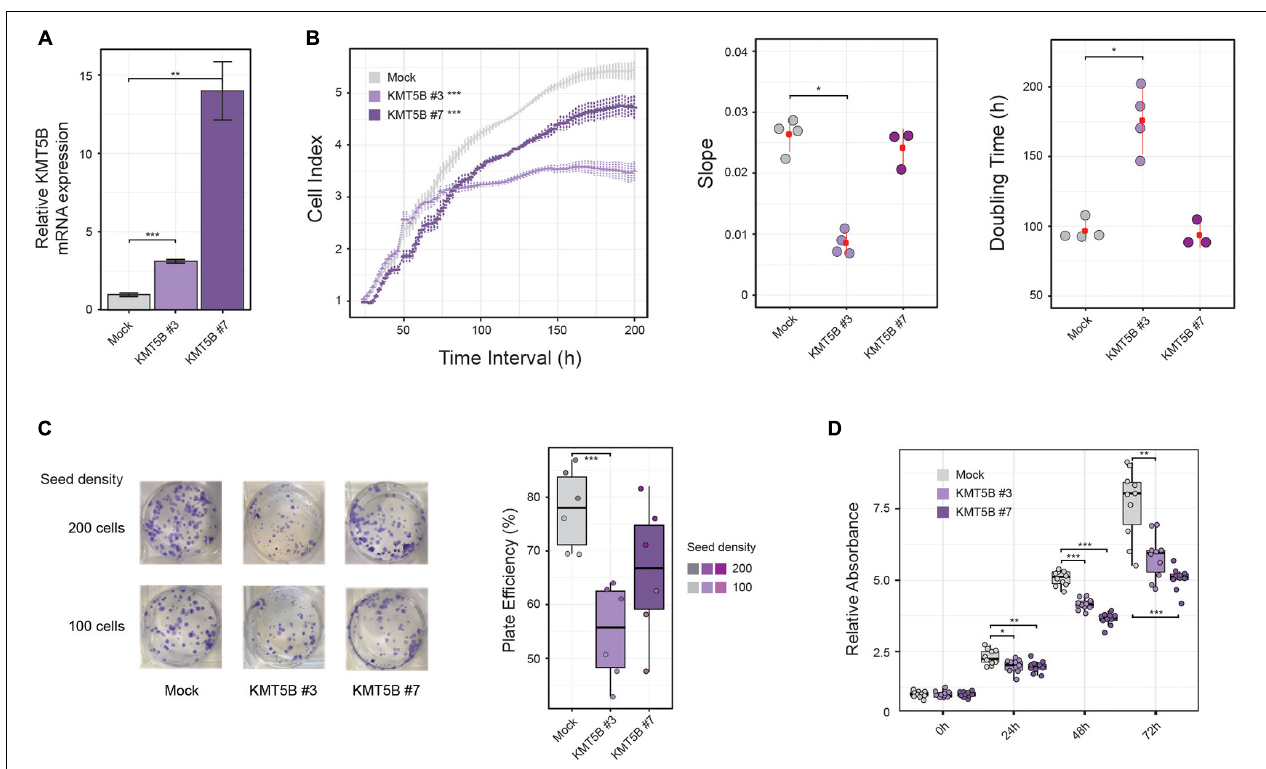
FIGURE 3 | In vitro effect of KMT5B ectopic expression. Human GBM cell line LN-229 was transfected with an empty (control) or a KMT5B expression vector. (A) Stable transfectants were obtained after selection with 1 mg/mL G-418, and named mock, KMT5B #3, and KMT5B #7. KMT5B expression was confirmed by qRT-PCR (the data shown are the average ± SEM of three independent experiments. Welch t -test; ** p < 0.01; *** p < 0.001). (B) The proliferation rate of mock and the two KMT5B stably-transfected clones was measured by an impedance-based assay and represented as cell index units [General linear model (GLM) *** p -value < 0.001], slope and doubling time for three to four technical replicates (Wilcoxon rank sum tests; * p -value < 0.05). (C) On the left, representative image of plates showing colony formation assay. Experiments were done in triplicate for each clone and seeding density. Results are represented in the box plot on the right as plate efficiency (Wilcoxon rank sum tests; *** p -value < 0.001). (D) Cell viability was determined by MTT assay on control and KMT5B transfected cells. Box plot represents the average absorbance of ten replicates at several time points, relative to the absorbance at time 0 h for each clone (Wilcoxon rank sum test; * p < 0.05; ** p < 0.01; *** p <